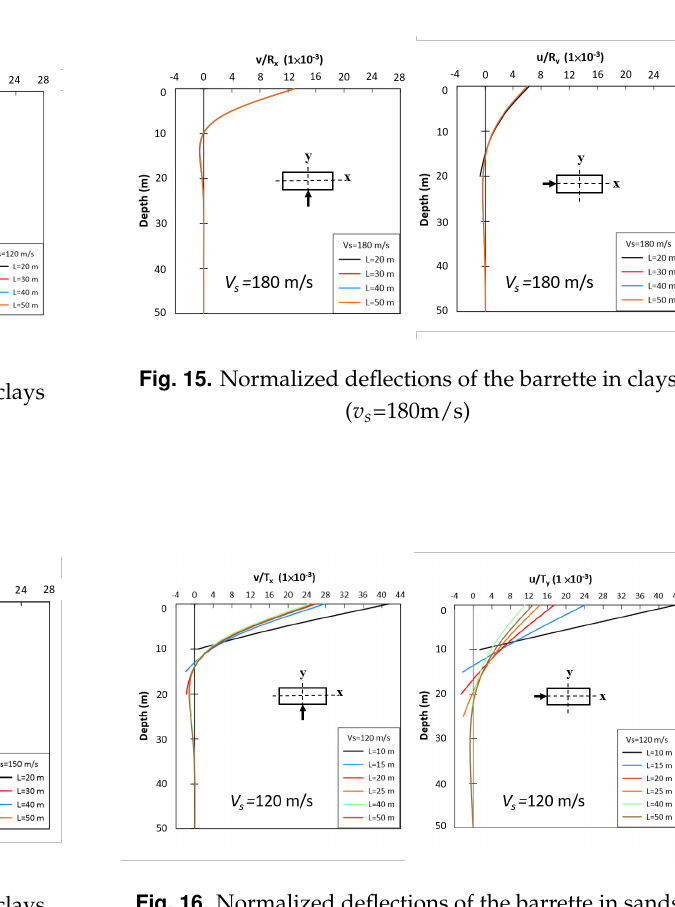
Fig. 14. Normalized deflections of the barrette in clays ( v s =150m/s)